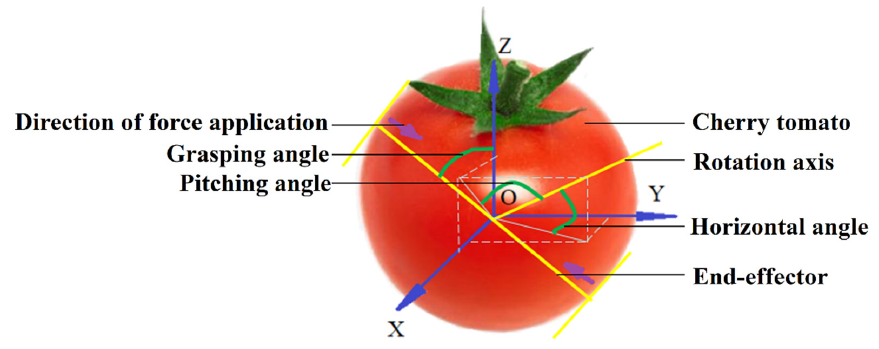
Figure 3. The relation of angle parameters in Cartesian coordinate system.